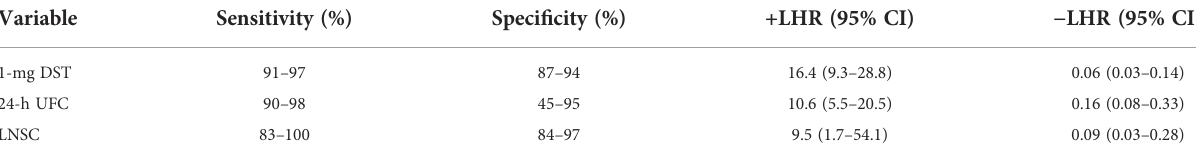
TABLE 1 Sensitivity and speci fi city and likelihood ratio of screening tests for Cushing syndrome (34 – 43).